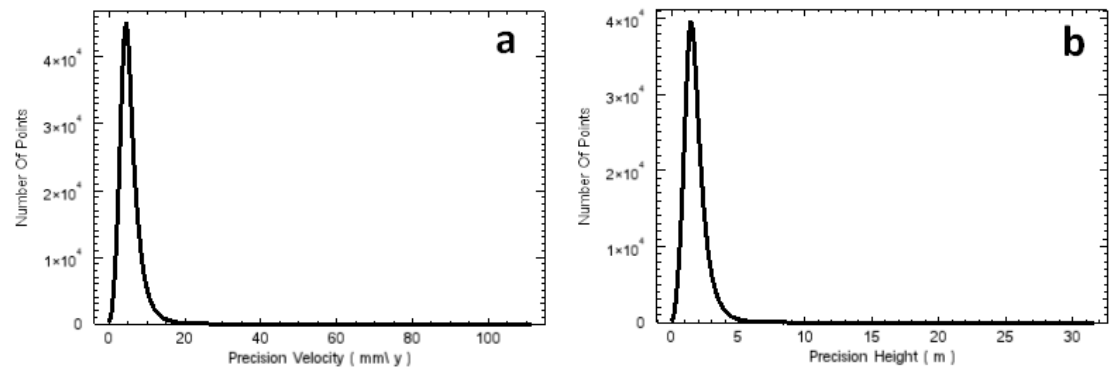
Figure 11. ( a ) Statistics histograms of velocity precision; and ( b ) the corresponding height precision.